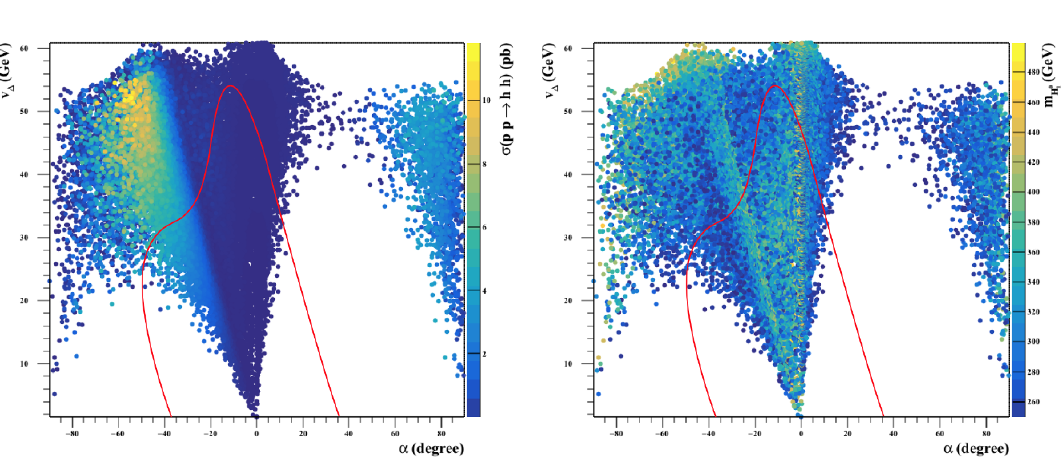
Figure 3 . Maximum production cross section (left) and the corresponding m (cid:11) - v (cid:1) plane, assuming BR ( H 0